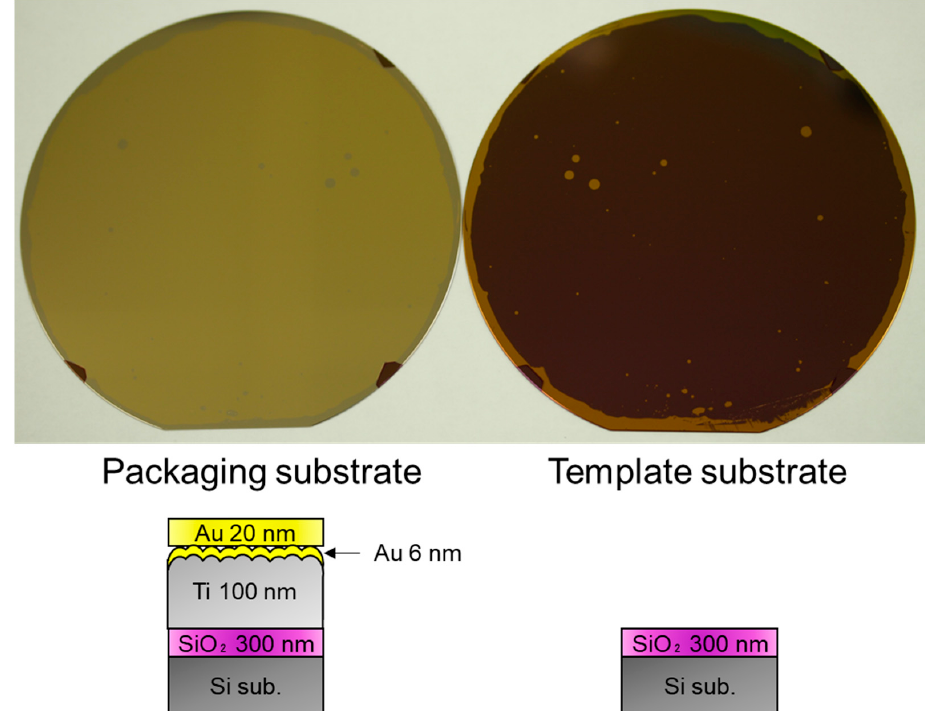
Figure 3. Getter film and template substrate after TS step.